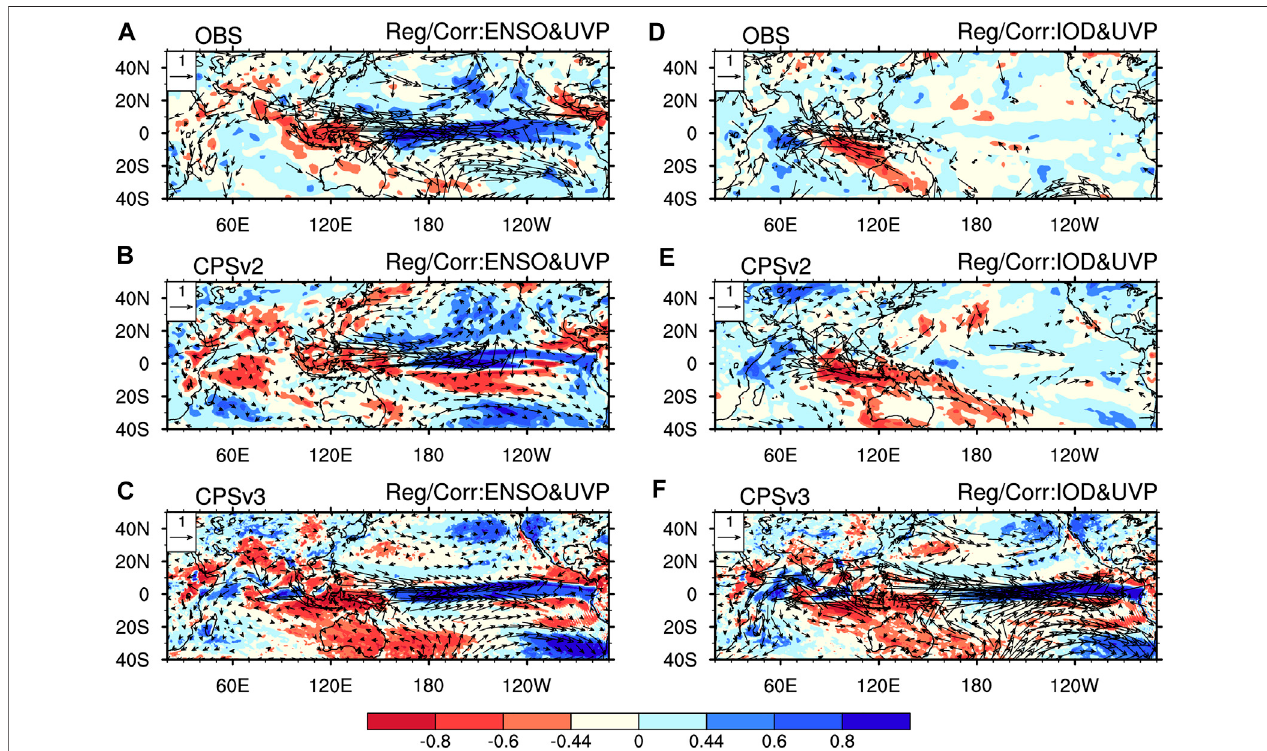
FIGURE 10 | Correlation coef fi cients (shading) between the SST index and rainfall and regression of 850 hPa winds (m s − 1 , vectors) against the SST index. (A – C) Nino3.4 index and (D – F) IOD index (the shading level above 0.44 represents the statistical signi fi cance of correlation above the 5% signi fi cance level).